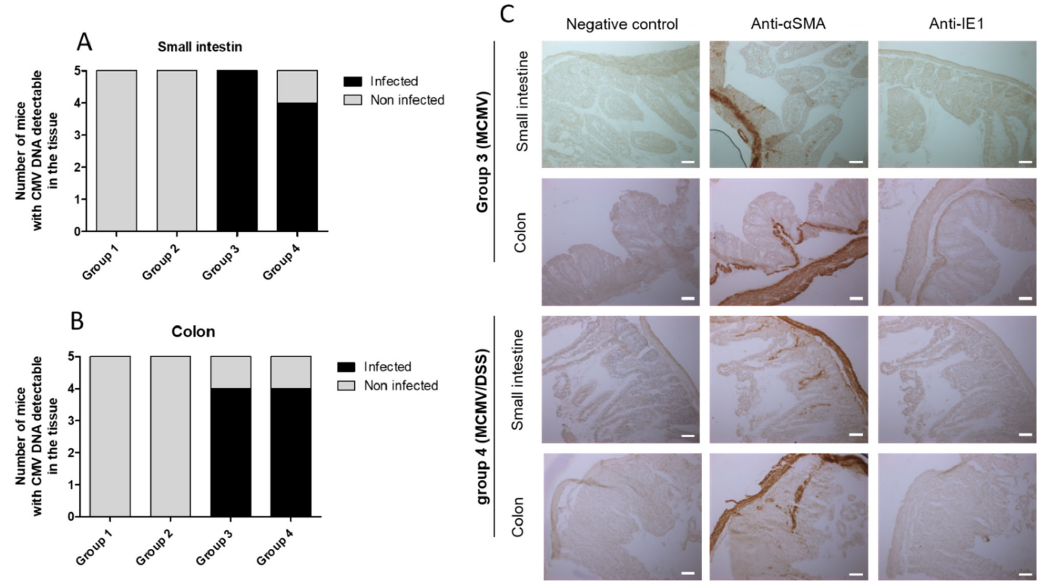
Figure 4. Exploration of MCMV reactivation in the gut of mice. ( A )—Proportion of mice for which murine cytomegalovirus (MCMV) DNA was detected in small intestine specimens by PCR; positive mice are shown in black and negative ones in grey. ( B )—For colon specimens. ( C )—Immunohisto ‐ chemistry at D37 (day of euthanasia) on gut specimens of a mouse of group 3 (upper part) or of group 4 (lower part). Staining corresponds to positive zones marked by horseradish peroxidase and revealed by diaminobenzidine substrate. The negative control was performed by omitting the pri ‐ mary antibody. The positive control was performed by using anti ‐ alpha smooth muscle actin (anti ‐ α SMA) as the primary antibody. The presence of a replicative virus was looked for by using an anti ‐ immediate early (IE) 1 protein of MCMV as primary antibody. The scale bar on images corresponds to 50 μ m. Photographs were taken at 20x objective in Zeiss Axioimager Apotome 3 optical micro ‐ scope with a Zeiss quadriCCD Axiocam camera.